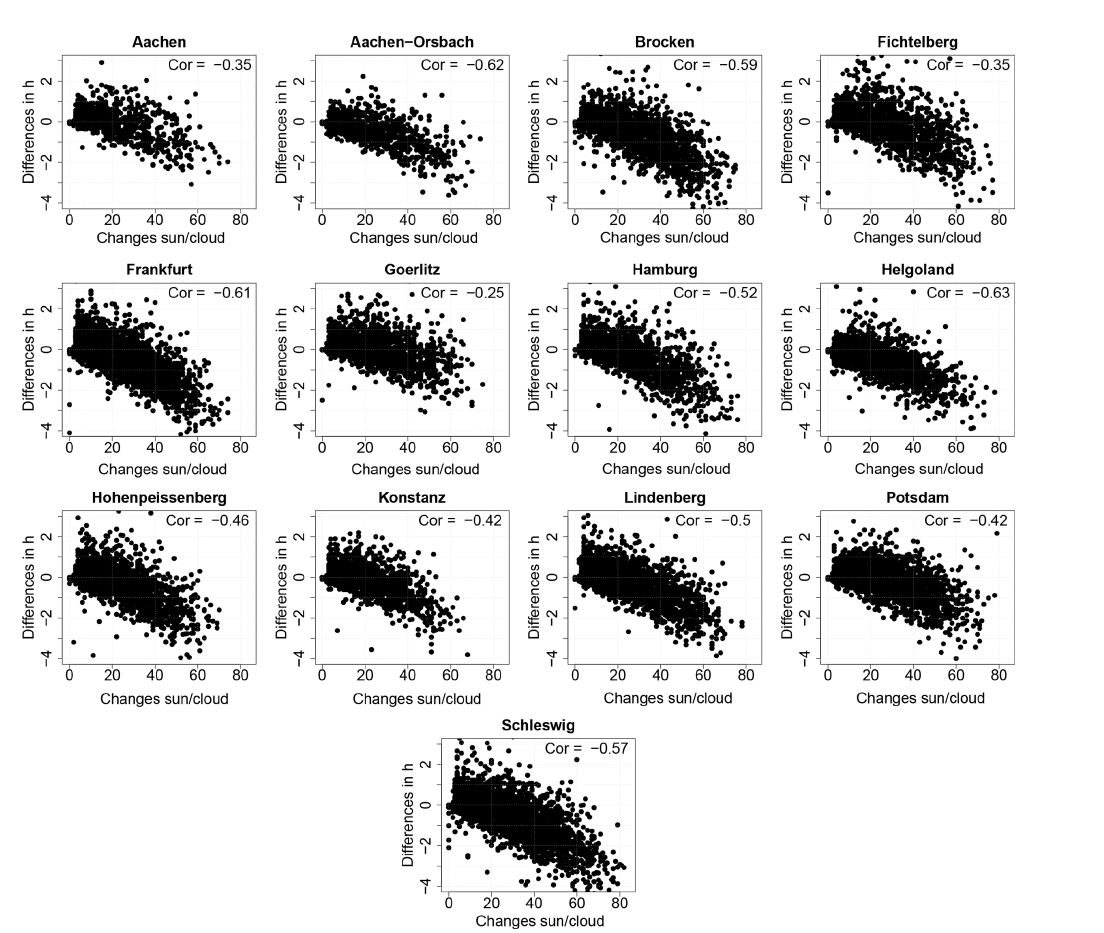
Figure 3. Scatterplot of differences of daily sunshine duration (automatic minus manual measurement) in hours and the daily changes between sunny and cloudy periods for all 13 climate reference stations and the correlation coefficients after